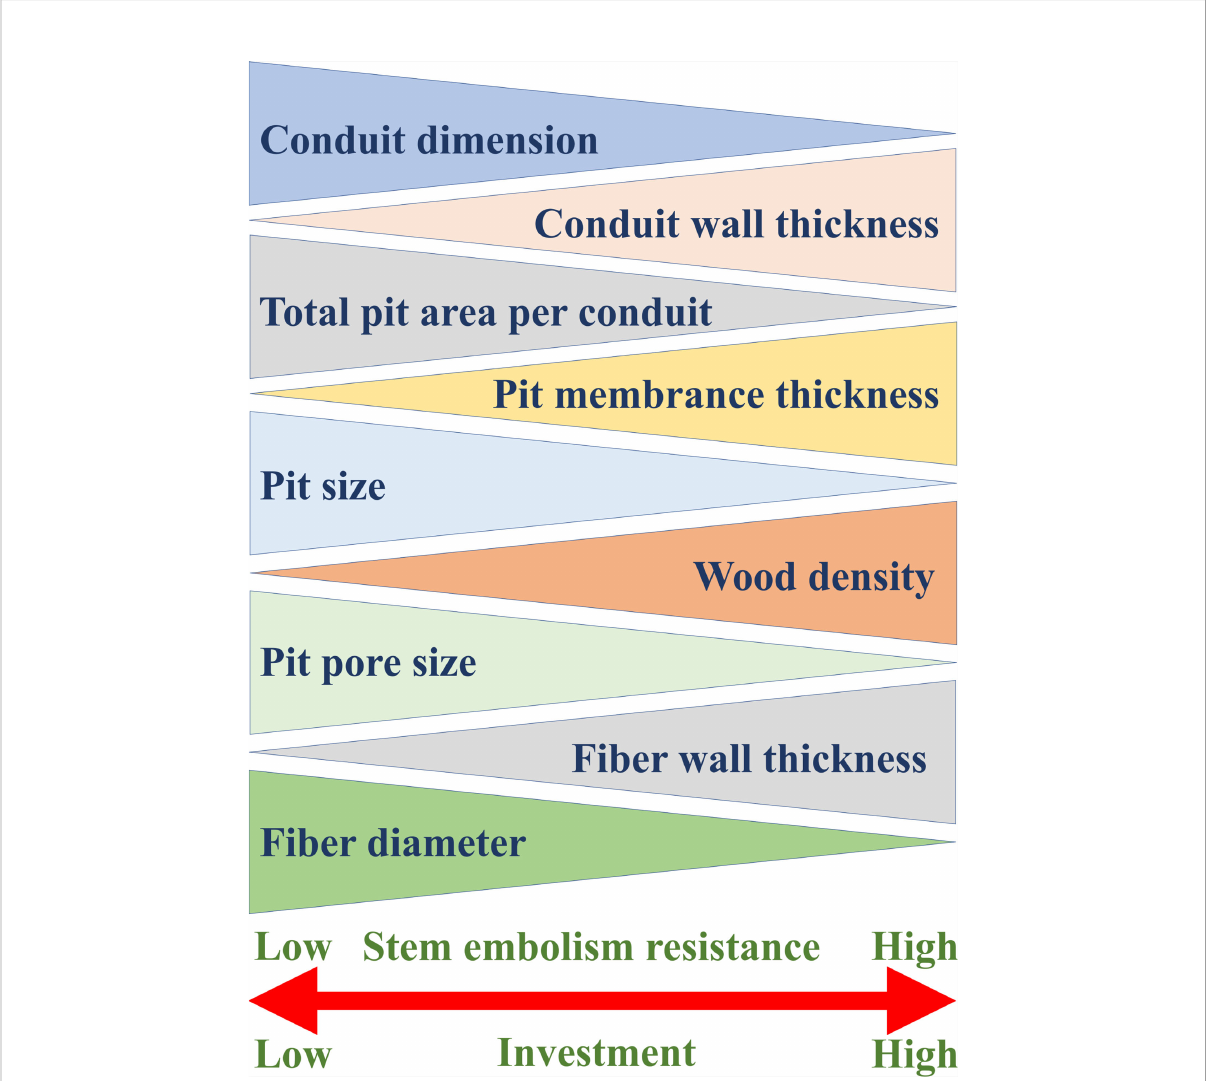
FIGURE 4 General xylem traits that determine stem embolism resistance and the relationships between these traits and stem embolism resistance. The thicker end of each triangle represents the higher value of the corresponding trait, and the xylem with stronger embolism resistance has greater construction